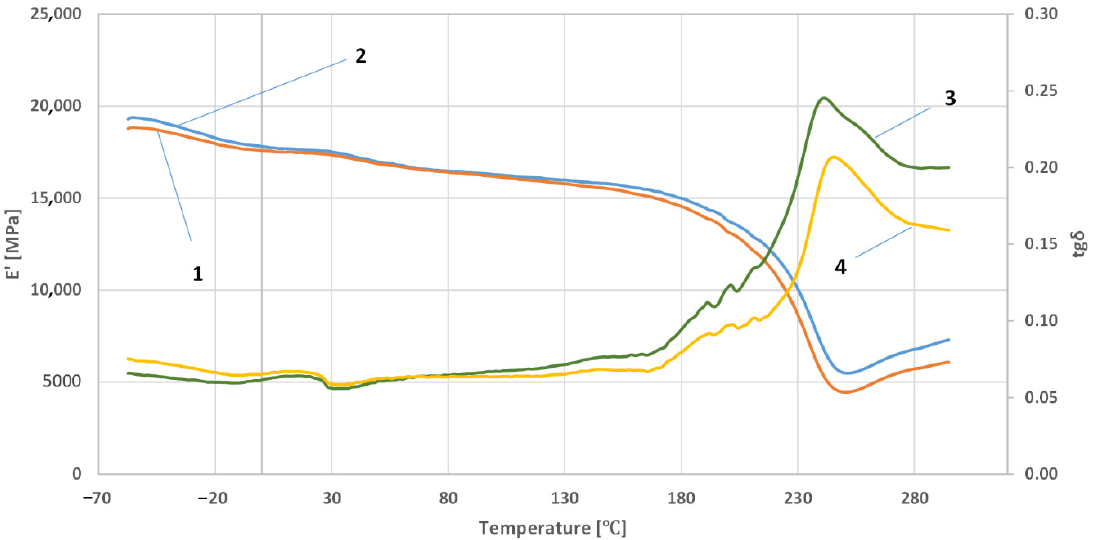
Figure 7. The dependence of the conservative modulus and the tangent of the mechanical loss angle on the temperature of the resin composite with brass chips: at a frequency of 1 Hz—1, 3; at a frequency of 10 Hz—2, 4.